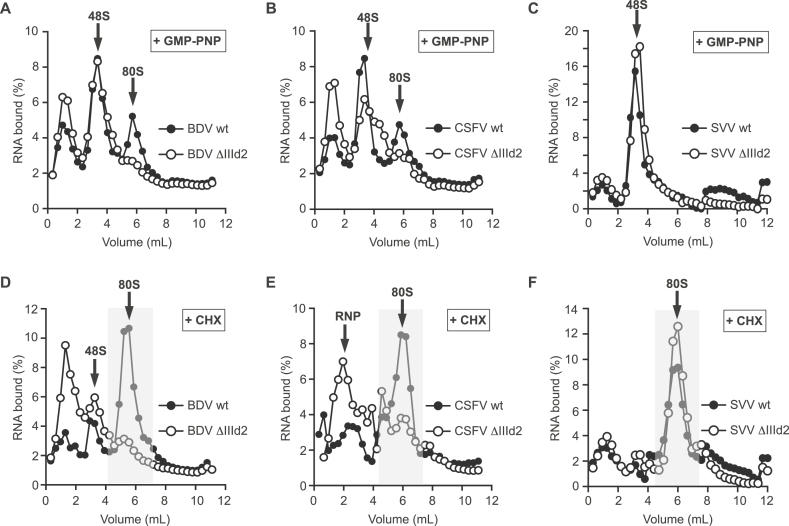
Assembly of ribosomal complexes on wt and mutant IRES transcripts as determined by centrifugation through 15–50% linear sucrose density gradients. Fractionation of initiation complexes formed after incubation of BDV (A and D) wt or ΔIIId2 IRES RNA transcripts, CSFV (B and E) wt or ΔIIId2 IRES transcripts and SVV (C and F) wt or ΔIIId2 IRES transcripts with RRL pre-treated with either GMP-PNP (A-C) or cycloheximide (CHX) (D–F). Arrows indicate the position of 48S complexes and 80S ribosomes. The profiles shown are representative of three independent experiments.